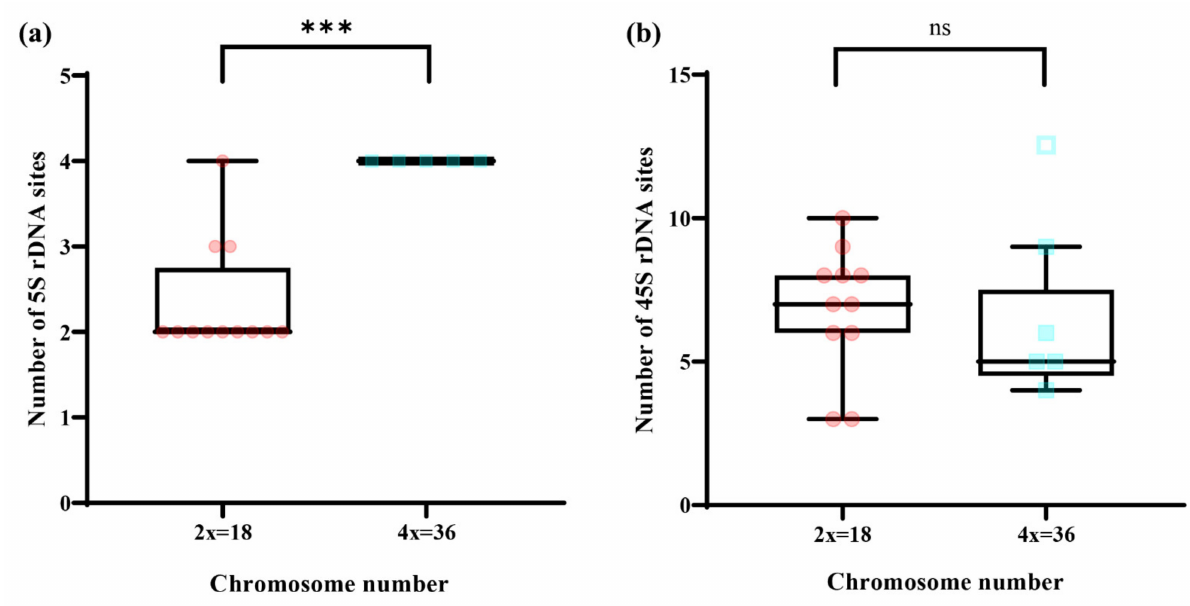
Figure 4. The number of rDNA sites versus the chromosome number (N = 18). The lines show the grouping of the ploidy levels into diploids and tetraploids according to t -test: ( a ) *** p < 0.001; ( b ) ns p > 0.05 (the hollow blue scatter point is the outlier and was excluded in t -test). Significantly, the 5S rDNA and 45S rDNA signals were colocalized on the same chromosome in diploid C. indicum (Wuhan, Hubei) (NAU031) (Figure 3a) and tetraploid C. indicum (Tianzhushan, Shaanxi) (NAU047) (Figure